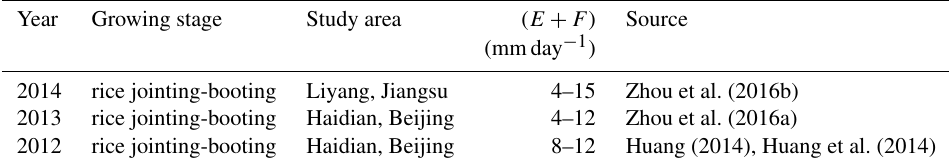
Table 1. ( E + F ) of different paddy fields using the same method.